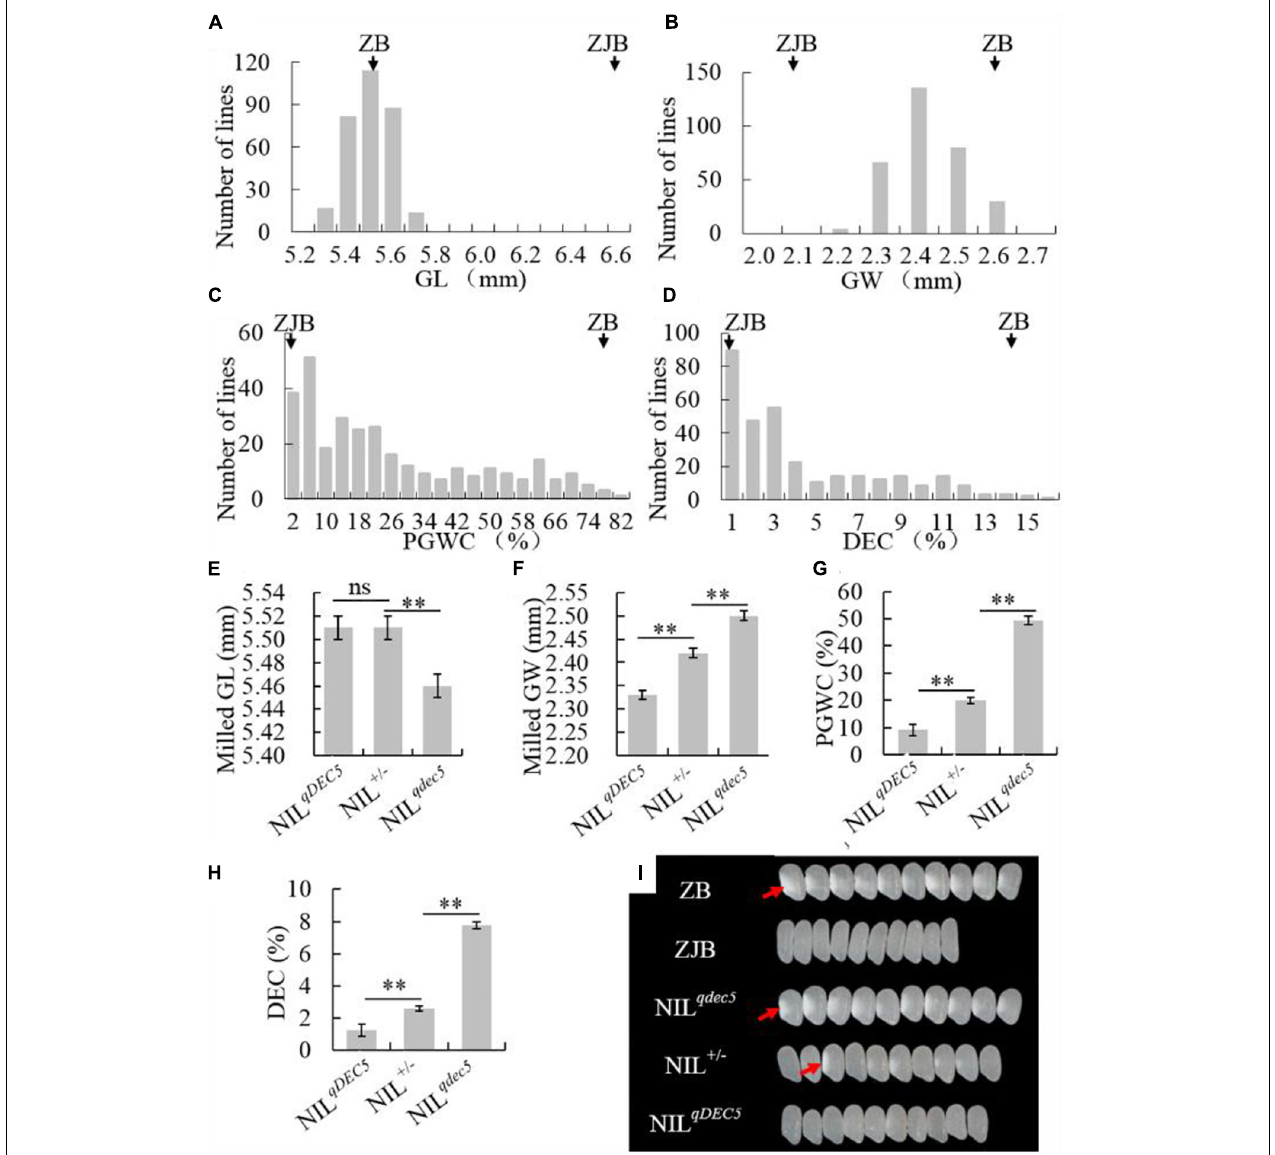
FIGURE 4 | The phenotype and genetic characteristics of grain shape and chalkiness traits. The distribution of the GL (A) , GW (B) , PGWC (C) , and DEC (D) traits in the NIL population. The average GL (E) , GW (F) , PGWC (G) , and DEC (H) values for three different groups of NILs (NIL qDEC 5 , NIL ± , and NIL qdec 5 ), where ZJB and ZB represent Zhenjia B and Zhenshan 97B, respectively, ** denotes a difference at a very significant level, and ns represents no signification. (I) Images of milled rice grains of ZB, ZJB, and the three different types of NILs, where the white parts (red arrows) represent rice chalkiness.